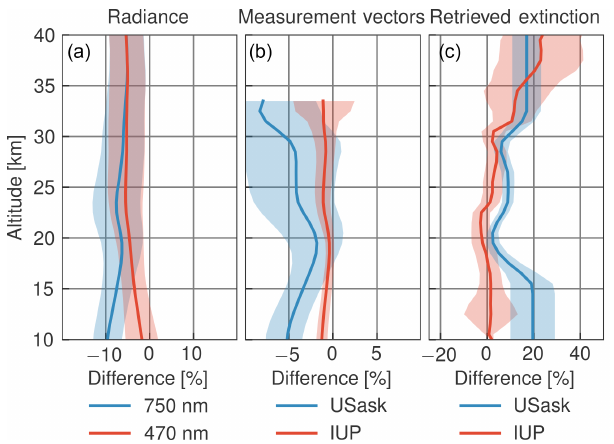
Figure 2. Comparisons of the radiative transfer models. Panel (a) shows the differences in radiance computed us- ing SASKTRAN and SCIATRAN. Panel (b) shows the difference in measurement vectors. Panel (c) shows the difference in retrieved profiles. Differences in panels (a) and (b) are computed as (SASKTRAN − SCIATRAN)/ (SASKTRAN + SCIATRAN) × 200%. Extinction error is com- puted as (retrieved − true)/true ×